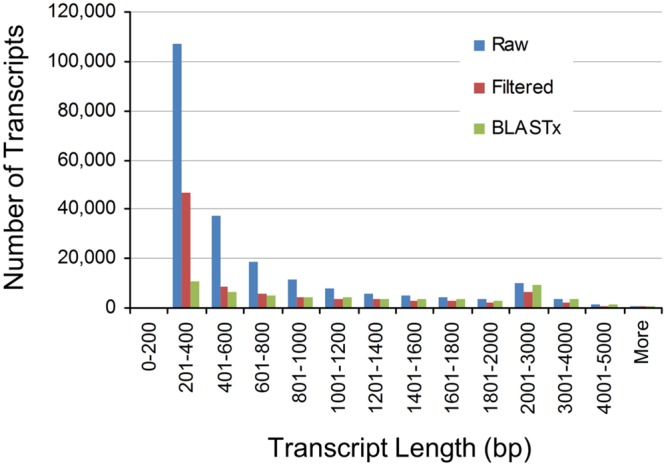
Length distributions of pokeweed mRNA transcriptomes.